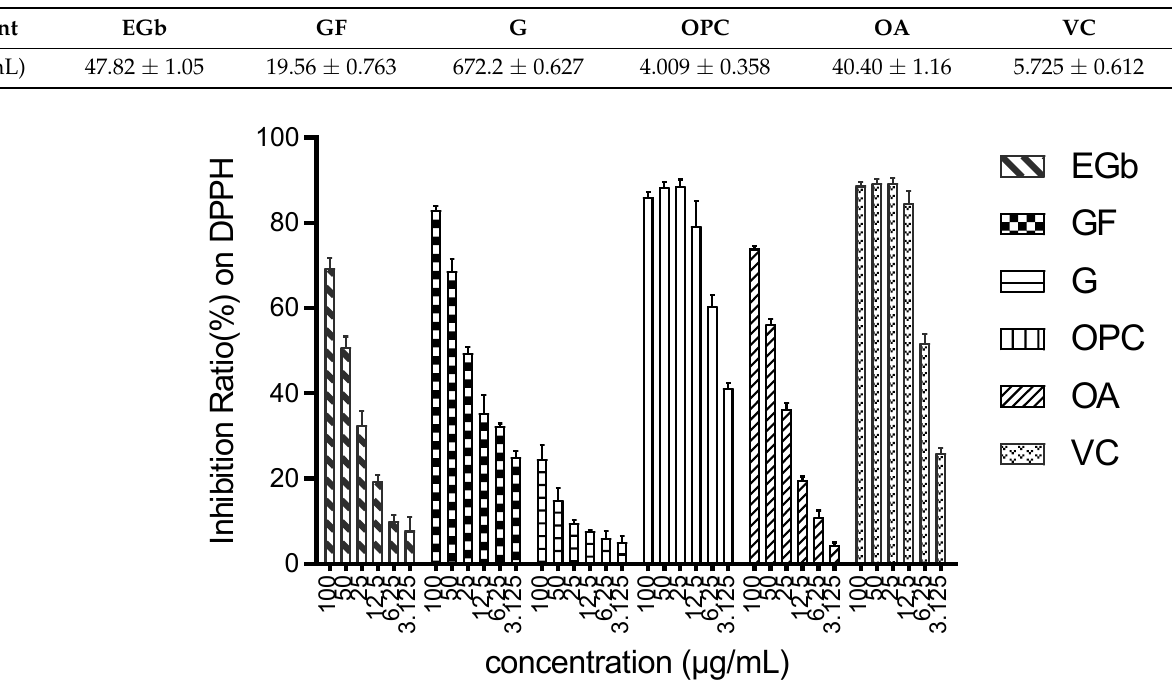
Table 1. The IC 50 value of DPPH radical scavenging from each functional component of EGb. ( Ginkgo biloba extract (EGb), ginkgo flavone (GF), ginkgolide (G), procyanidins (OPC), and organic acids (OA) ).